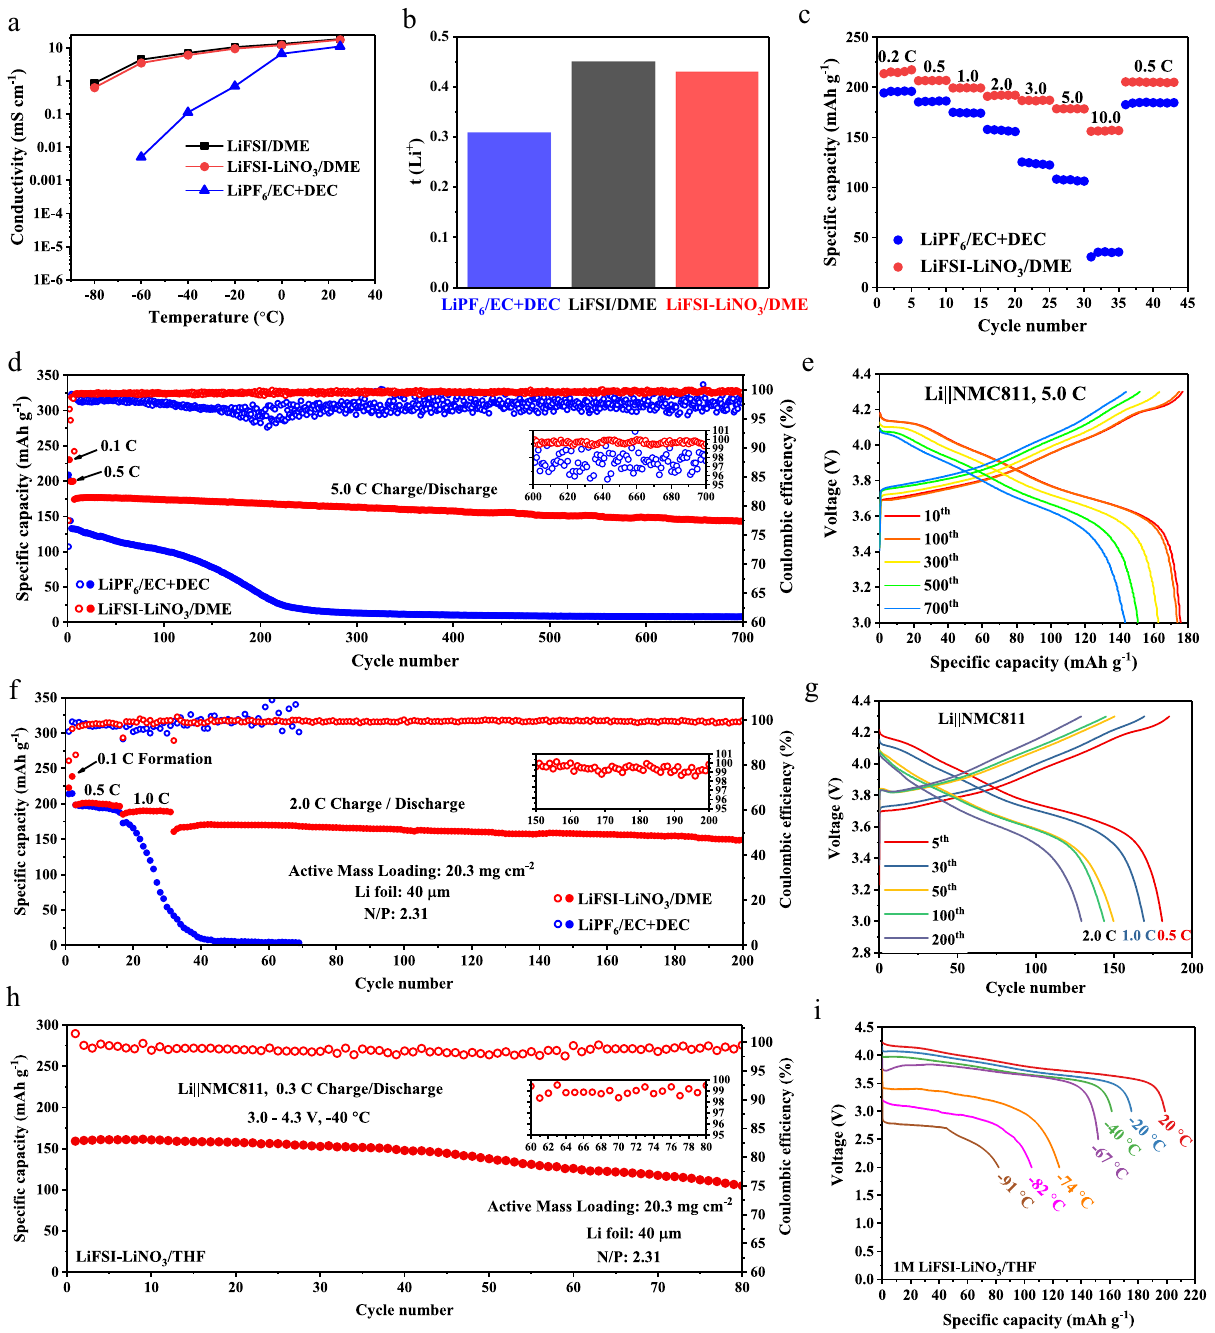
Fig. 3 Comparison of transport and electrochemical properties between the ether-based electrolyte and carbonate-based electrolyte. a Conductivity versus temperature. b Li + transference number (t Li + ) computed from DC polarization measurements at 10 mV using the Bruce – Vincent method. c Rate capability of Li | |NMC811 cells under different charging/discharging rates. d Long-term superfast charging/discharging performance of Li | |NMC811 cells using different electrolytes at 5.0 C rate. e the corresponding voltage pro fi les at different cycles of Li | |NMC811 cells using LiFSI – LiNO 3 /DME at 5.0 C rate. f Long-term cycling performances of high-voltage Li | |NMC811 full batteries with 40 μ m Li anode. The N/P ratios of the Li | |NMC811 cell were 2.31. The fi rst two formation cycles were carried out at a 0.1 C rate, followed by 15 cycles at 0.5 C rate, sequential 15 cycles at 1.0 C rate and the long-term cycling was at 2.0 C rate. g The corresponding voltage pro fi les of high-voltage Li | |NMC811 full batteries using LiFSI – LiNO 3 /DME. h Cycling performance of full cells in LiFSI – LiNO 3 /THF electrolyte at − 40 °C and 0.3 C rate. i Discharge pro fi les of Li | |NMC811 cells using LiFSI – LiNO 3 /THF electrolyte at different